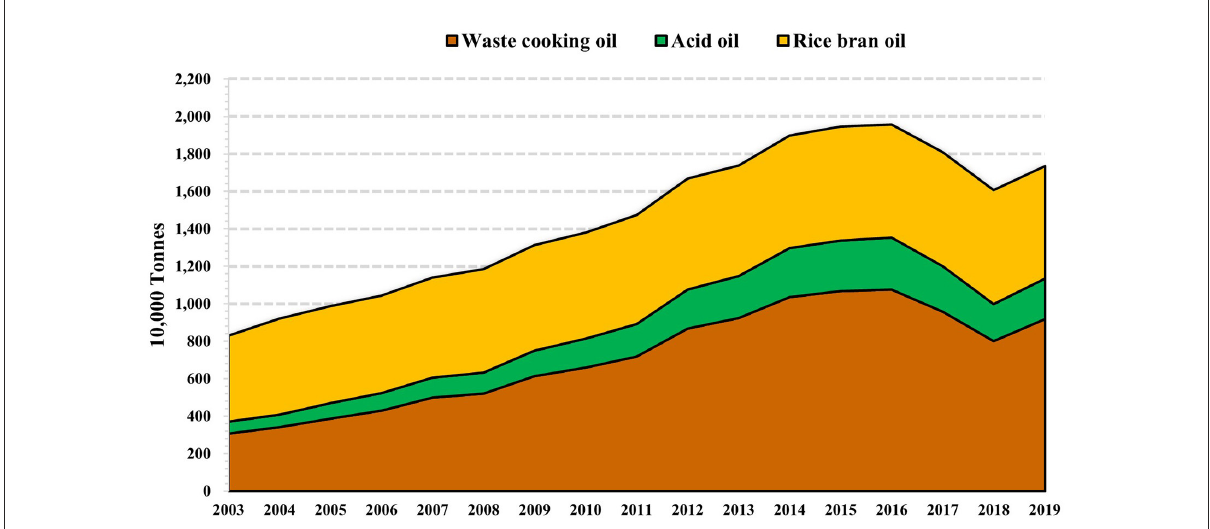
FIGURE1 The potential supply of WCO, acid oil, and rice bran oil in China between 2003 and 2019. The calculation formula is from Liang et al. (2013). Data are from the China Statistical Yearbooks 2004–2020 (NBS,